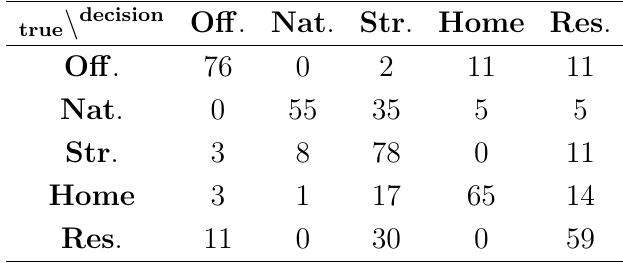
Table 11. Confusion matrix of five environment classes office , nature , street/road , home and restaurant/pub/cafe before adaptation.